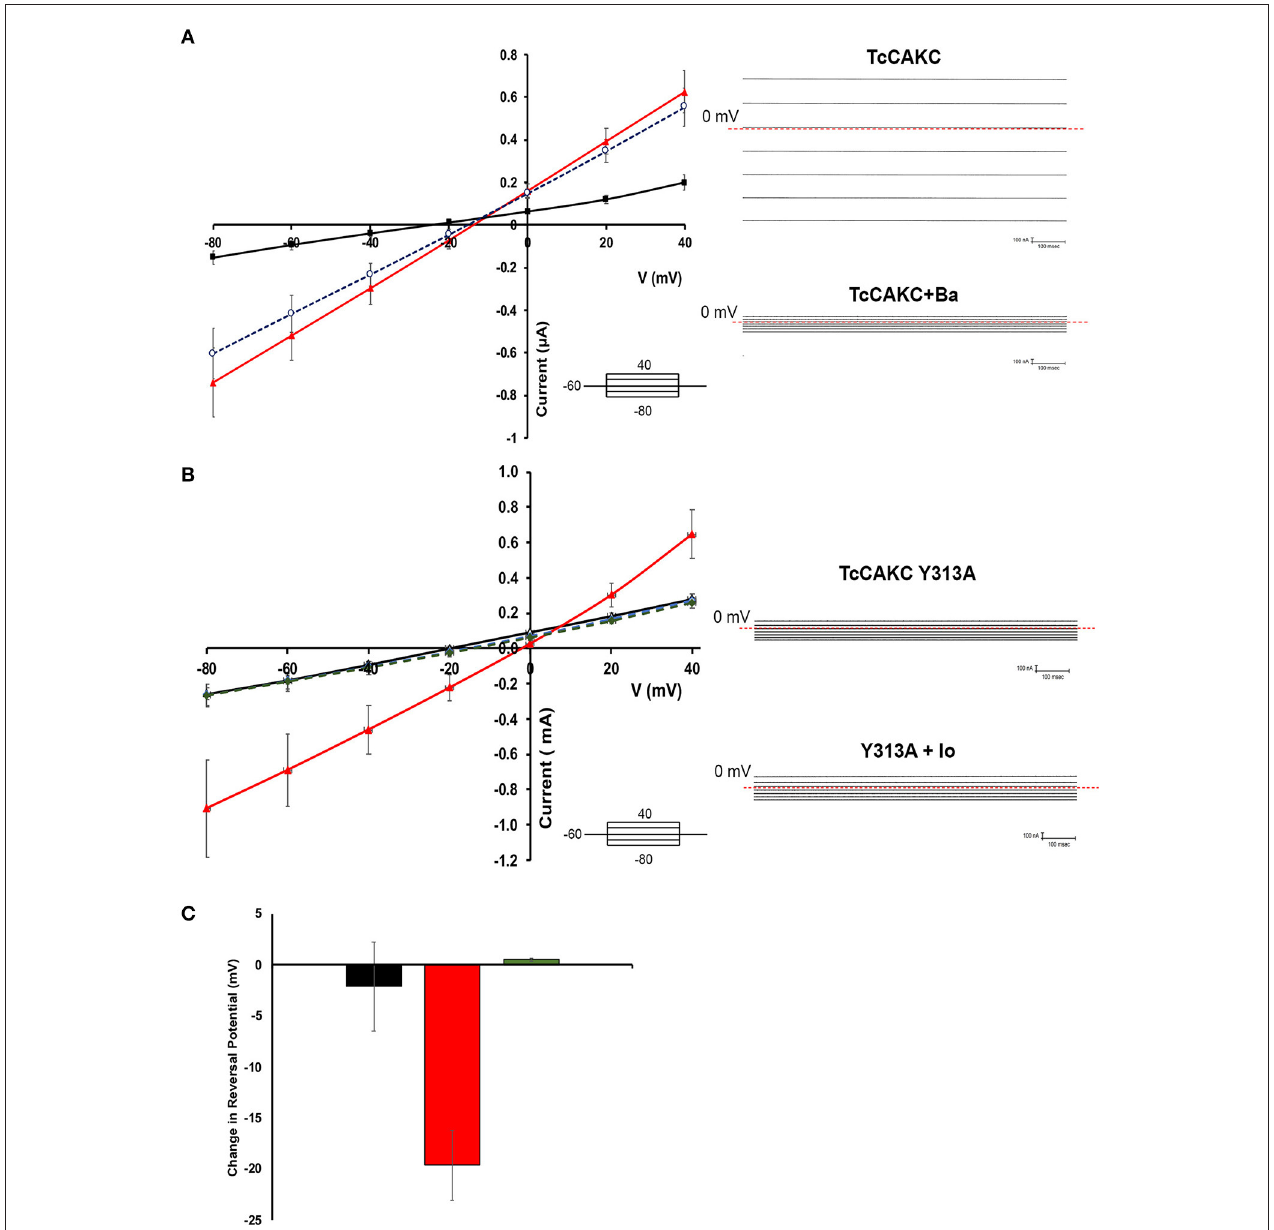
FIGURE 3 | Blockage characteristics of TcCAKC. (A) Current-voltage relationship showing the effect of potassium channel blockers on thapsigargin-elicited TcCAKC currents (red line). One millimolar of extracellular BaCl 2 significantly reduced the current (black line) while up to 300 µ M 4-AP had no significant effect. Values are Mean ± SD of n = 10 oocytes from 3 independent days or recording. Representative traces are shown in the right panel. (B) Current-voltage relationship of oocytes expressing WT TcCAKC in absence (black line) or presence (red line) of ionomycin or TcCAKC-Y313A mutant (doted green and blue lines). Values are Mean ± SD of n = 15 oocytes from 3 independent experiments. Representative traces are shown in the right panel. (C) Quantification of the reversal potential calculated from the currents obtained under ramp protocols in control oocytes (black), cells expressing TcCAKC (red) or TcCAKC-Y313A (green)Values are Mean ± SD of n = 35 oocytes from 7 independent